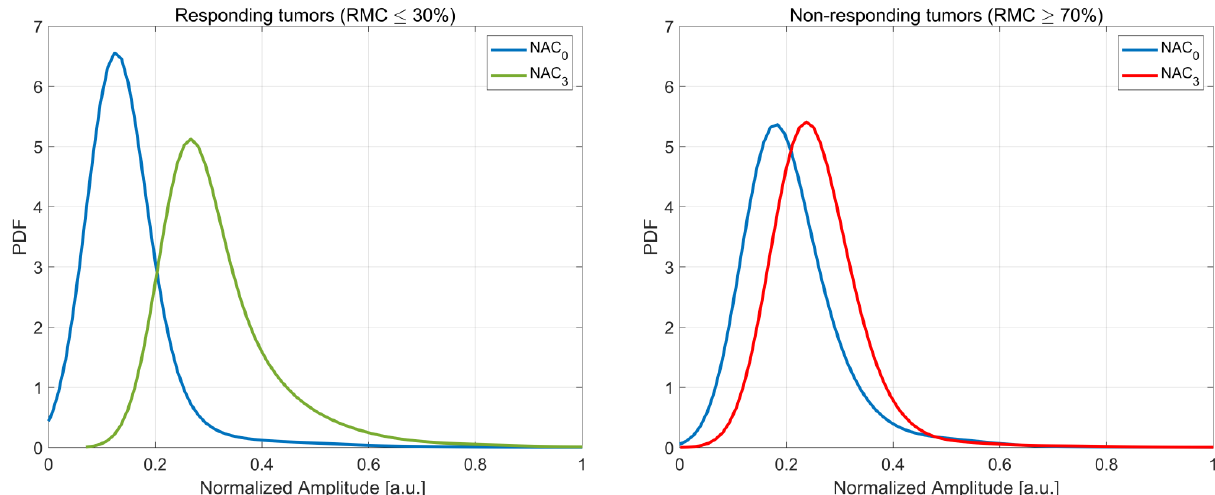
Figure 2. Average probability density (PDF) function for backscatter amplitude obtained for responders (RMC ≤ 30%) and non-responders (RMC ≥ 70%). Data were recorded before chemotherapy (NAC 0 ) and after cycle 3 (NAC 3 ).